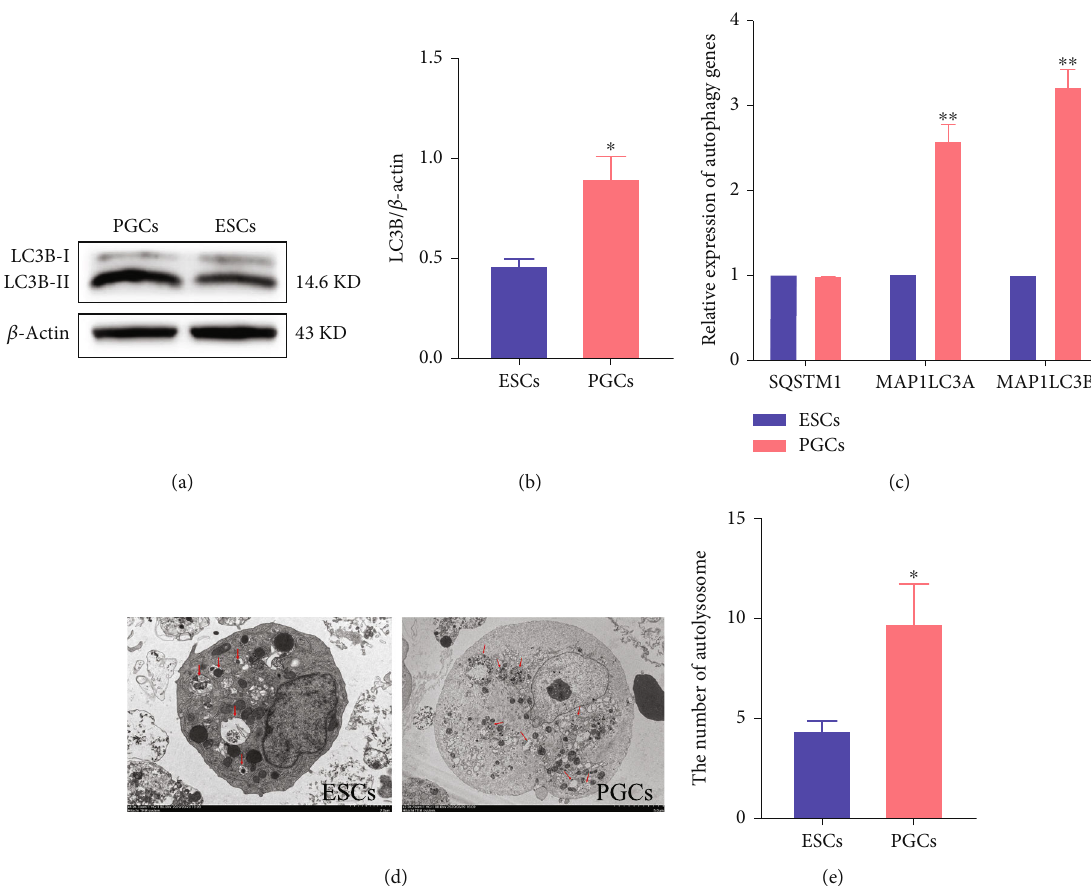
Figure 4: Detection of autophagy in ESCs and PGCs. (a, b) The expression of autophagy related protein in ESCs and PGCs was detected using western blot and the gray scale analysis of western blot. (c) The expression of autophagy related genes in ESCs and PGCs was detected by qRT-PCR. ∗ p < 0 : 05 , ∗∗ p < 0 : 01 (d) Autolysosomes in ESCs and PGCs were observed under transmission electron microscopy, marked with red arrows. (e) The number of autolysosomes in ESCs and